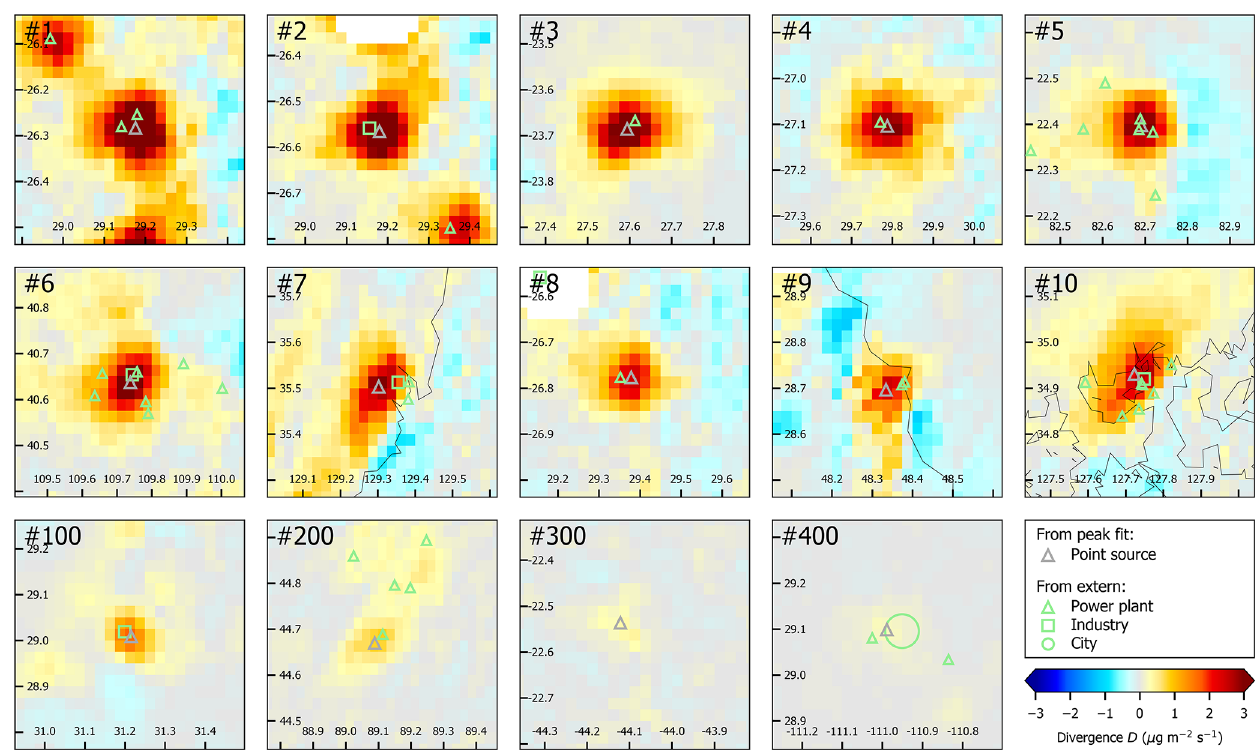
Figure 5. Divergence maps for the selected point sources listed in Table 4. In addition to the location of the fitted Gaussian peak (grey), also some external information on GPPD power plants as well as industrial facilities and cities is added (green). Table 4. Extract of the point source catalog for the top 10 and every 100th rank. Power plant capacity, fuel type, and facility names are added for matches to GPPD. The last two columns are not part of the catalog but have been added manually for the presented selection in order to provide information on the likely NO x source where no (or insignificant) GPPD match has been found. Divergence maps for the same selection are displayed in Fig. 5. As discussed in detail in Sect. 5.2.6, the given emissions are biased low. Respective tables for regional top emitters are listed in the Supplement for all considered